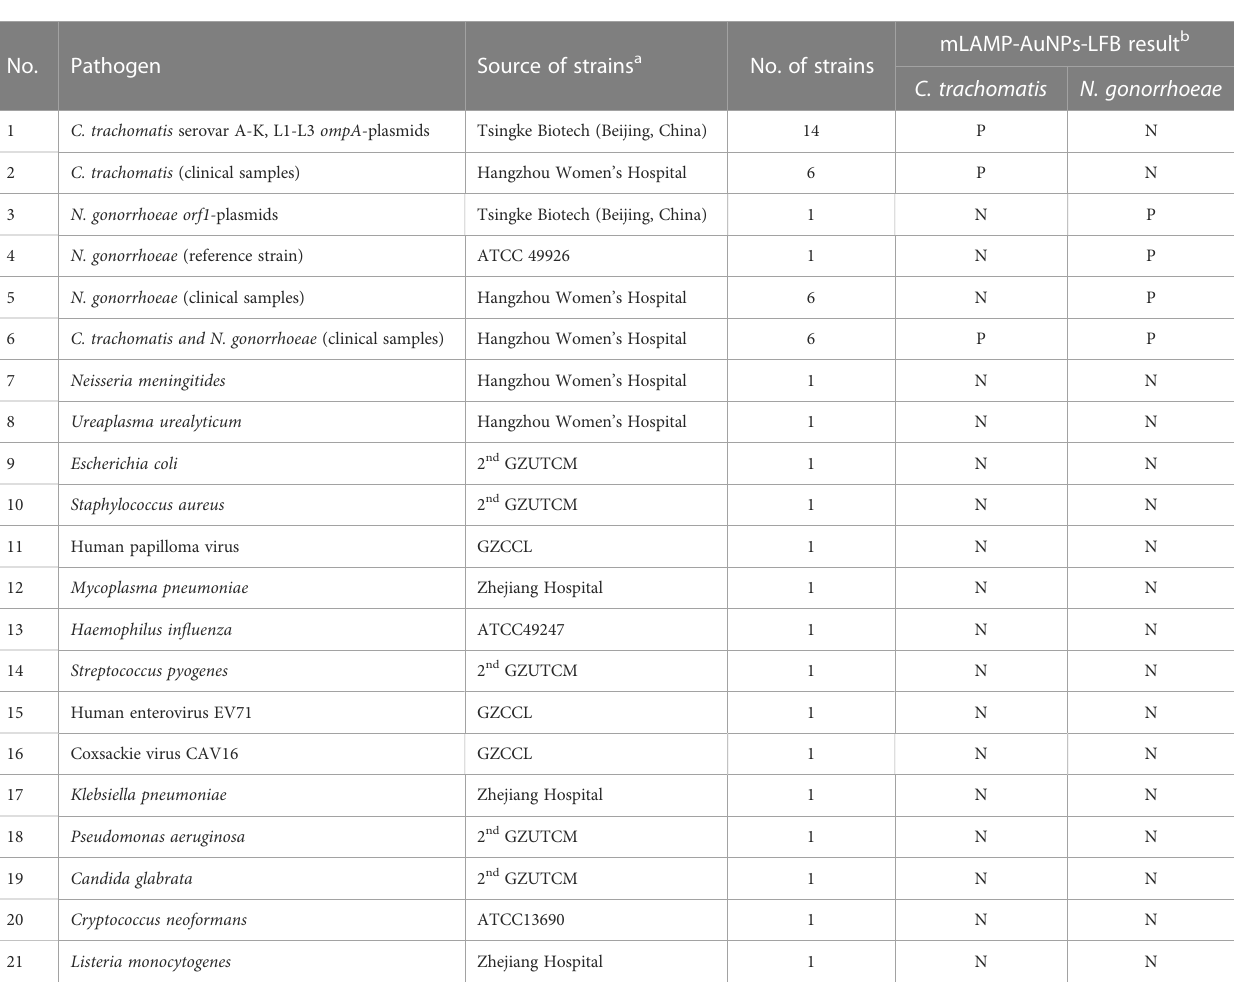
TABLE 1 Microbial strains used in this